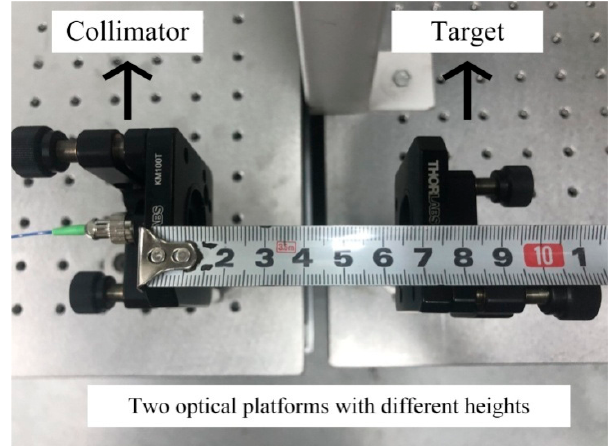
Figure 7. The target mirror and collimating lens placed on different platforms.